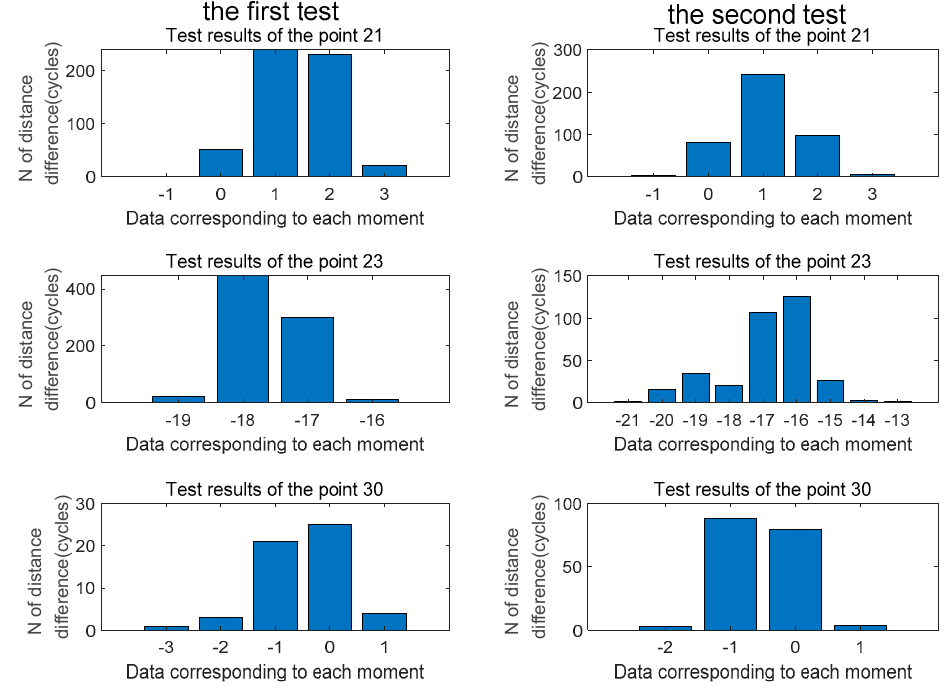
Figure 16. The probability statistical distribution map of 21, 23, and 30 points.